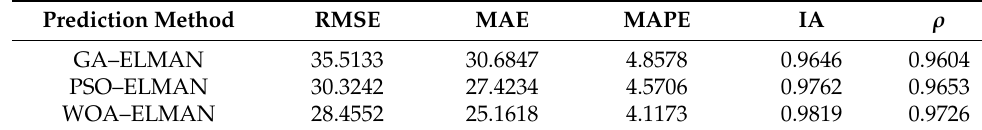
Table 1. Error evaluation index value of each prediction model under various optimisation algo- rithms.